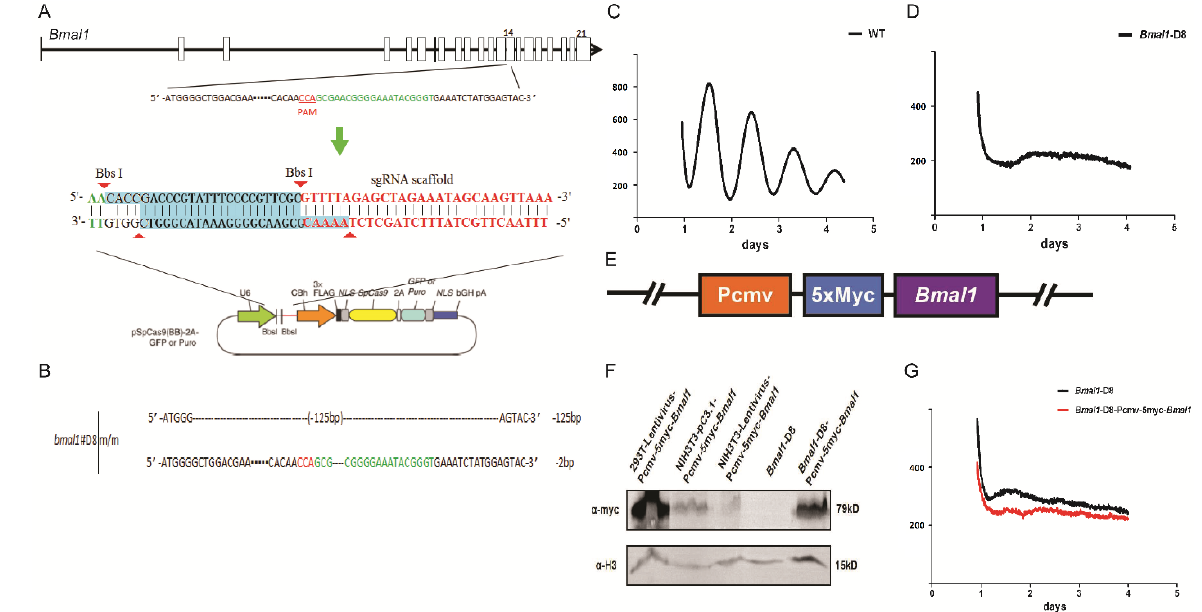
Figure 1. NIH3T3 cells with Bmal1 − / − genotypes are arrhythmic. ( A ) The schematic diagram of sgRNA design information and knockout vector construction of the Bmal1 gene is shown. On the top, the schematic of Bmal1 was drawn. In the enlarged region at the 14th exon, the bases marked in green are the sequence of the picked sgRNA. Then, the sgRNA sequence was cloned into the px459 vector. ( B ) A monoclonal cell line, Bmal1 -D8, showed that both alleles of the Bmal1 gene were edited. According to the analysis on the predicted mRNA, neither edited alleles of Bmal1 is capable of producing functional Bmal1 proteins. ( C ) The luminescence recording of the WT NIH3T3 cells that bear with a luciferase reporter under the Bmal1 promoter. ( D ) The bioluminescence rhythm of the Bmal1 -D8 cells, which is arrhythmic. ( E ) Illustration of the main components of the constructed lentiviral vector to complement the Bmal1 gene. The Bmal1 coding sequence tagged with five constitutive myc tags is under the CMV promoter. ( F ) Myc epitope tags as a label to detect whether the cells are successfully transfected with exogenous Bmal1 . In several cell lines, 293T, NIH3T3, and Bmal1 -D8 cells, lentiviral constructs can successfully express Bmal1 proteins. Histone3 is shown as a loading control. Histone3 is shown as a control. ( G ) However, both Bmal1 -D8 and Bmal1 -D8 cells supplemented with lentivirus were arrhythmic. Representative luminescent trace or image was shown.